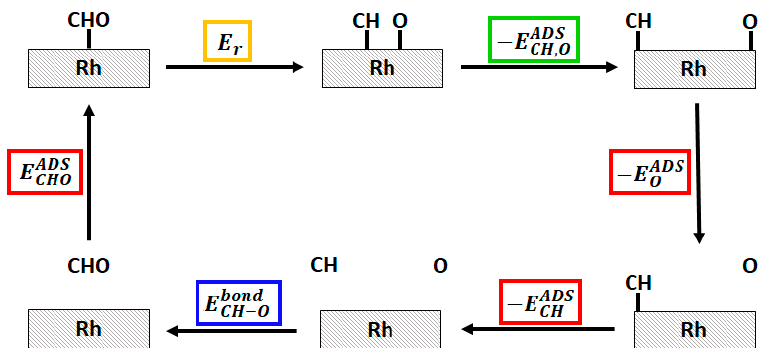
Figure 7. Hess cycle of the decomposition of the CHO* → CH* + O* reaction energy E r (highlighted in yellow). The three main contribution, namely the adsorption energies ( E ADS ) of CHO*, CH* and O*, the CH–O bond strength in the free CHO species ( E bond ), and the CH*–O*co-adsorption energy CH − O ( E ADS ) are highlighted in red, blue and green CH , O